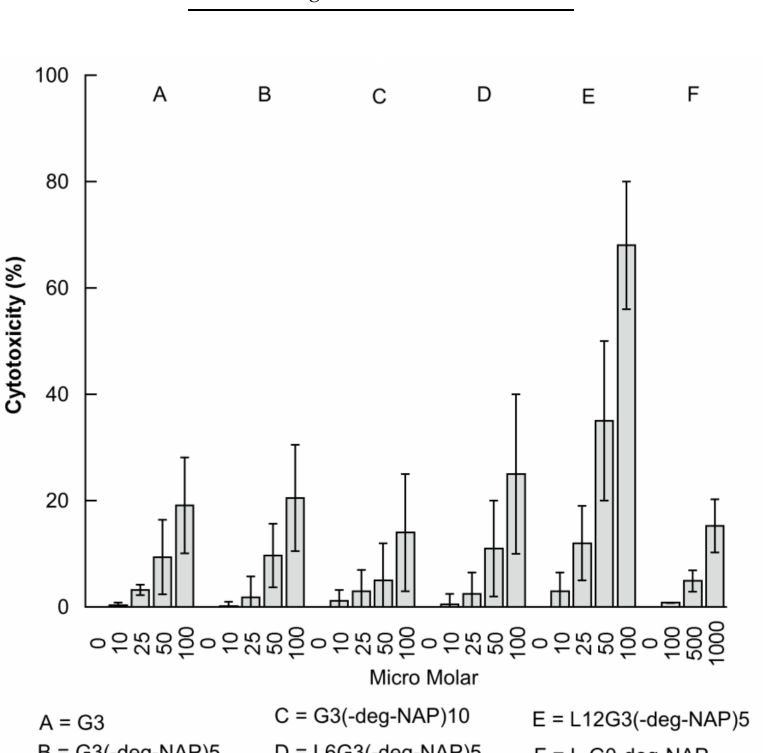
Figure 6. The effect of G3 PAMAM dendrimer, G3-naproxen conjugates (LyG3-(deg-NAP)x), and L-G0-deg-NAP on the viability of Caco-2 cells (LDH assay) (mean ± S.D., n =